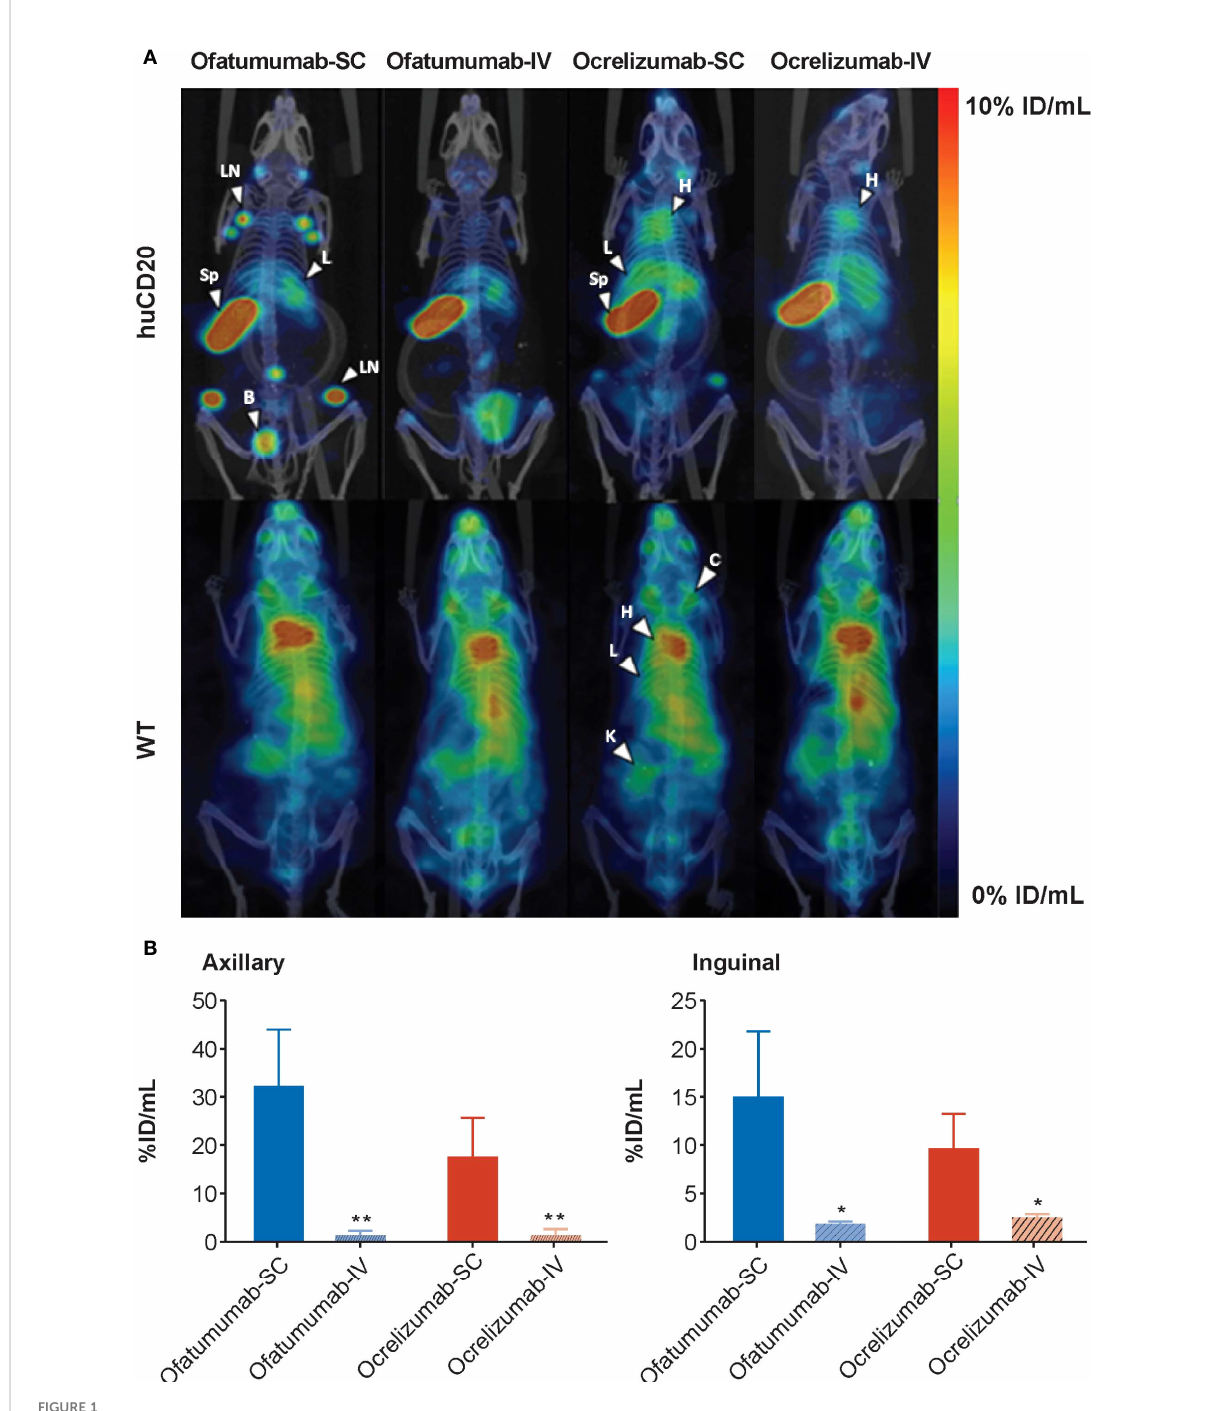
FIGURE 1 (A) Representative maximum intensity projection (MIP) SPECT/CT images of huCD20 (upper panel) and WT (lower panel) mice 72 h after SC or IV administration of 111 In-ofatumumab or 111 In-ocrelizumab. Prominent binding of 111 In-ofatumumab and 111 In-ocrelizumab is observed in lymph nodes of huCD20 mice following SC administration, but not after IV administration. Both 111 In-ofatumumab and 111 In-ocrelizumab displayed similar tissue distributions. No speci fi c binding was observed in WT mice. B = bladder, C = clavicle, H = heart, K = kidney, L = liver, LN = lymph node, Sp = spleen (B) VOI analysis of SPECT/CT imaging (N = 5 per group). A signi fi cantly higher level of binding was observed in axillary and inguinal lymph nodes of huCD20 mice following SC versus IV administration. * p < 0.05; ** p < 0.01. Data represent mean ±